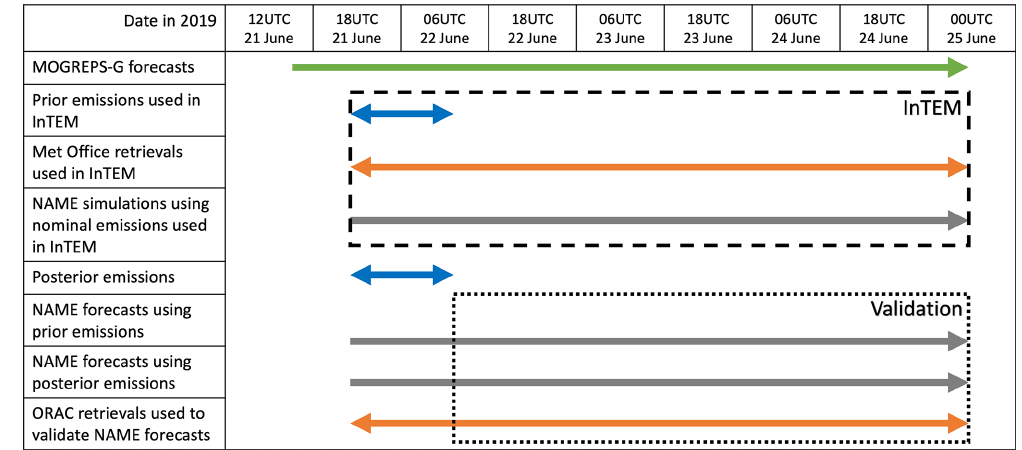
Figure 1. Timeline showing start and end of volcanic emissions used in the NAME simulations (blue arrows), satellite retrievals used for source inversion and validation (orange arrows), meteorological forecast data period (green arrow) and NAME simulation length (grey arrows). Single-headed arrows represent forecasts and double-headed arrows represent volcanic ash emission and observation data periods. The dashed box surrounds data sources used in the InTEM source inversion and the dotted box surrounds data used in the